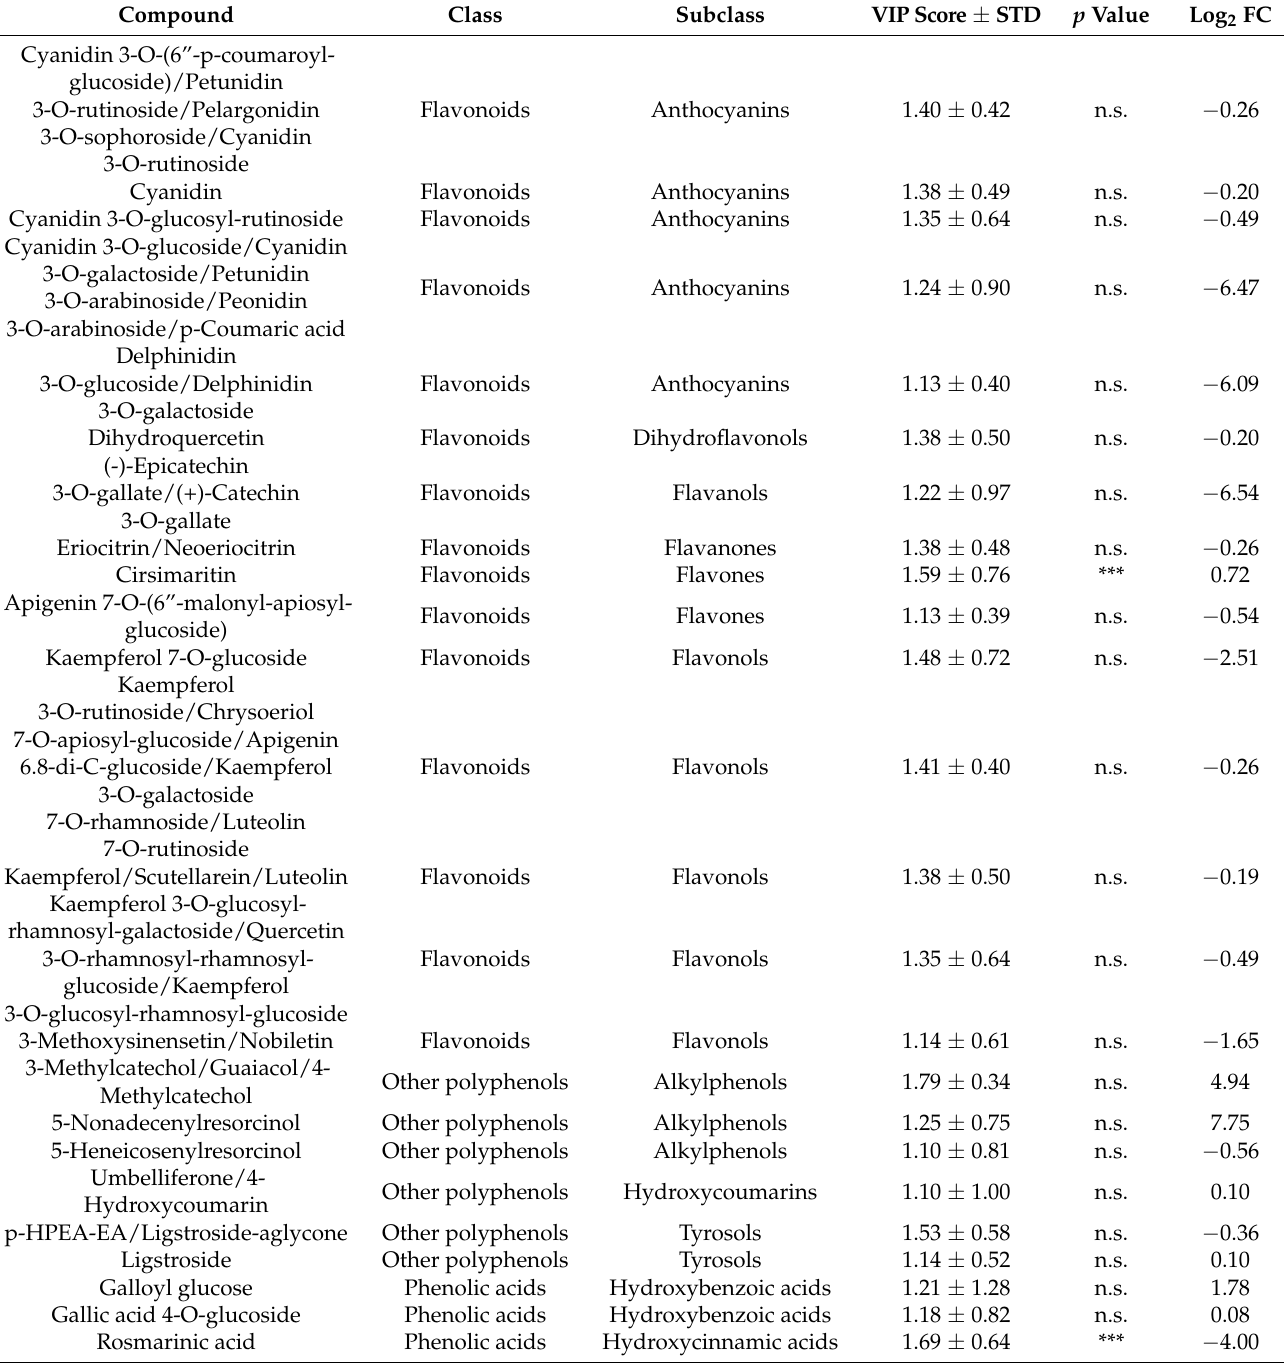
Table 3. Discriminant phenolic compounds identified in leaves according to VIP associated with the OPLS-DA model reported in Figure 4a (effect of UV treatment). Phenolic compounds, classified according to their class and subclass, are provided with p value and their Log 2 FC calculated in respect to control samples. ** p < 0.01, *** p < 0.001, n.s., not